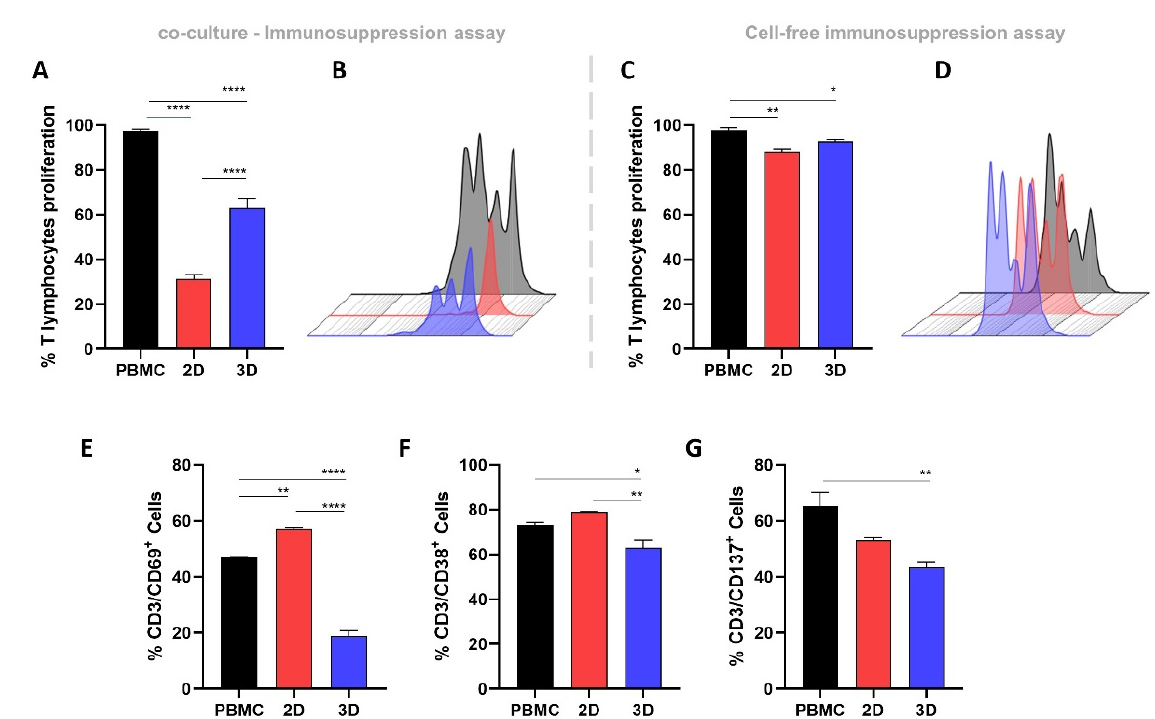
Figure 2. Determination of T ‐ cell proliferation and activation. ( A ) The 2D ‐ MSCs and 3D ‐ MSCs inhibited T ‐ cell proliferation in 72 h of co ‐ culture. ( B ) Representative CFSE histograms of PHA ‐ activated PBMCs (black), PHA ‐ activated PBMCs cultured with 2D ‐ MSCs (red), and PHA ‐ activated PBMCs cultured with 3D ‐ MSCs (blue). ( C ) The 2D ‐ MSCs’ and 3D ‐ MSCs’ secretomes inhibited T ‐ cell proliferation in 72 h of culture. ( D ) Representative CFSE histograms of PHA ‐ activated PBMCs (black), PHA ‐ activated PBMCs cultured with 2D ‐ MSCs secretome (red), and PHA ‐ activated PBMCs cultured with 3D ‐ MSCs secretome (blue). ( E ) The 2D ‐ MSCs promoted and 3D ‐ MSCs inhibited CD69 expression on T ‐ cells in 24 h of co ‐ culture. ( F , G ) The 3D ‐ MSCs inhibited CD38 and CD137 expression on T ‐ cells in 24 h of co ‐ culture. * p < 0.05; ** p < 0.01; **** p < 0.0001.